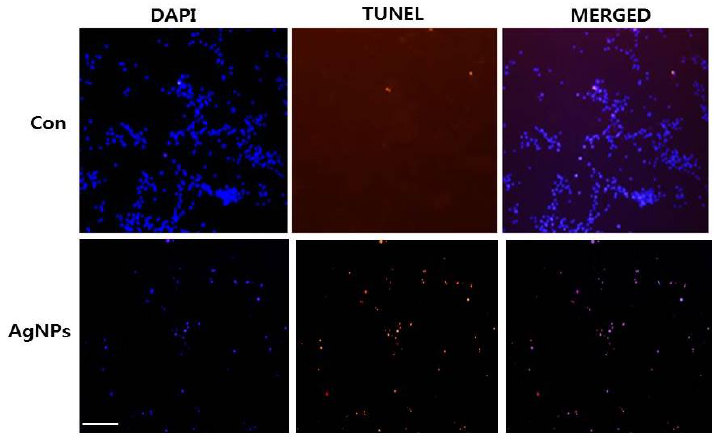
Figure 6. AgNP-induced apoptosis in HCT116 cells. HCT116 cells were treated with AgNPs for 24